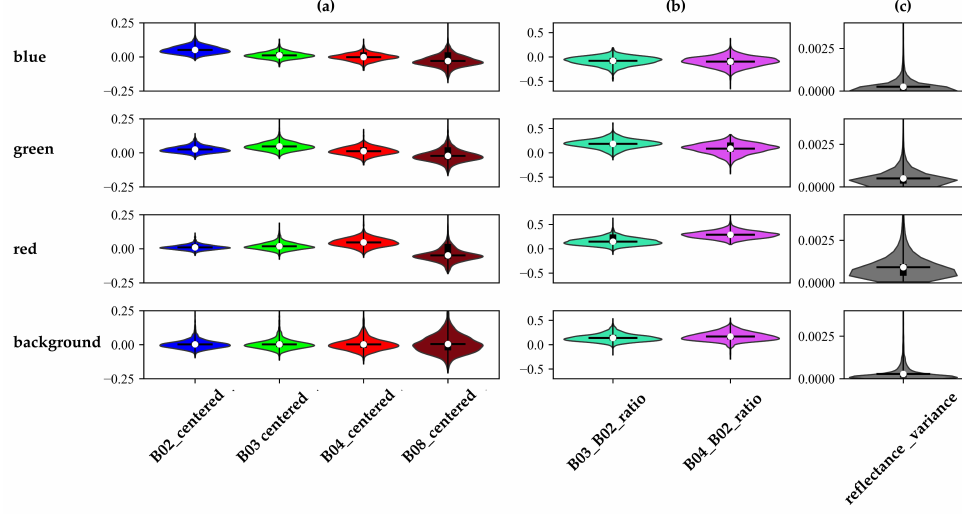
Figure 6. Statistics of training features by class: ( a ) Centered band reflectances. ( b ) Band ratios. ( c ) VIS